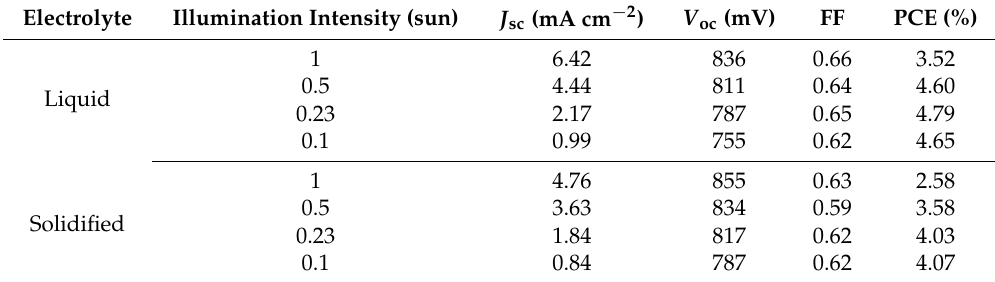
Table 1. Electrical parameters derived from J-V curves on DSCs based on liquid and solidified electrolytes, under different levels of light illumination. Adapted and reprinted with permission from